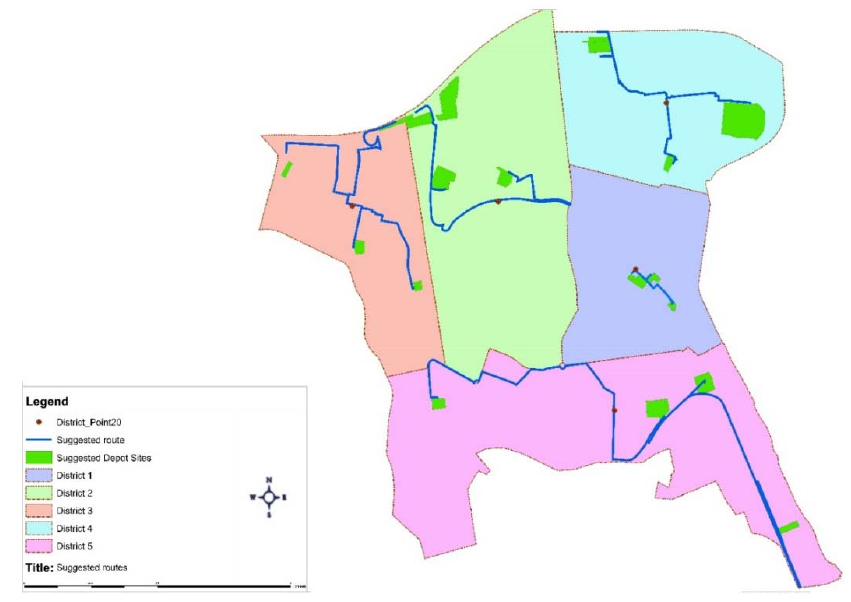
Fig. 2: Debris evacuation routs in Ray City Table 3: Necessary manpower for debris removal in the Ray earthquake scenarios Job